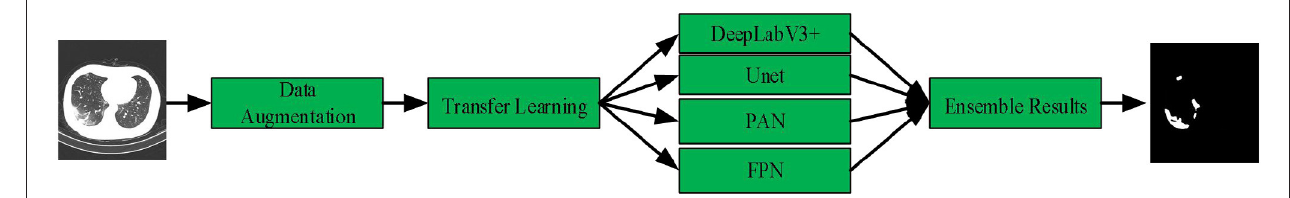
FIGURE 3 | A pipeline for COVID-19 lesion segmentation in CT images.